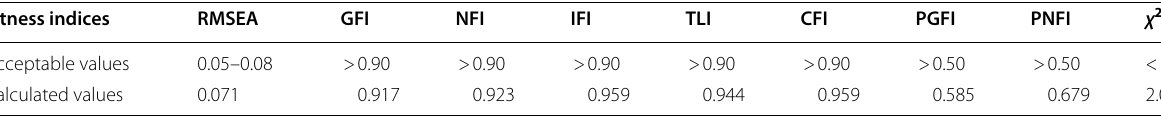
Table 6 Fitness indices for the proposed